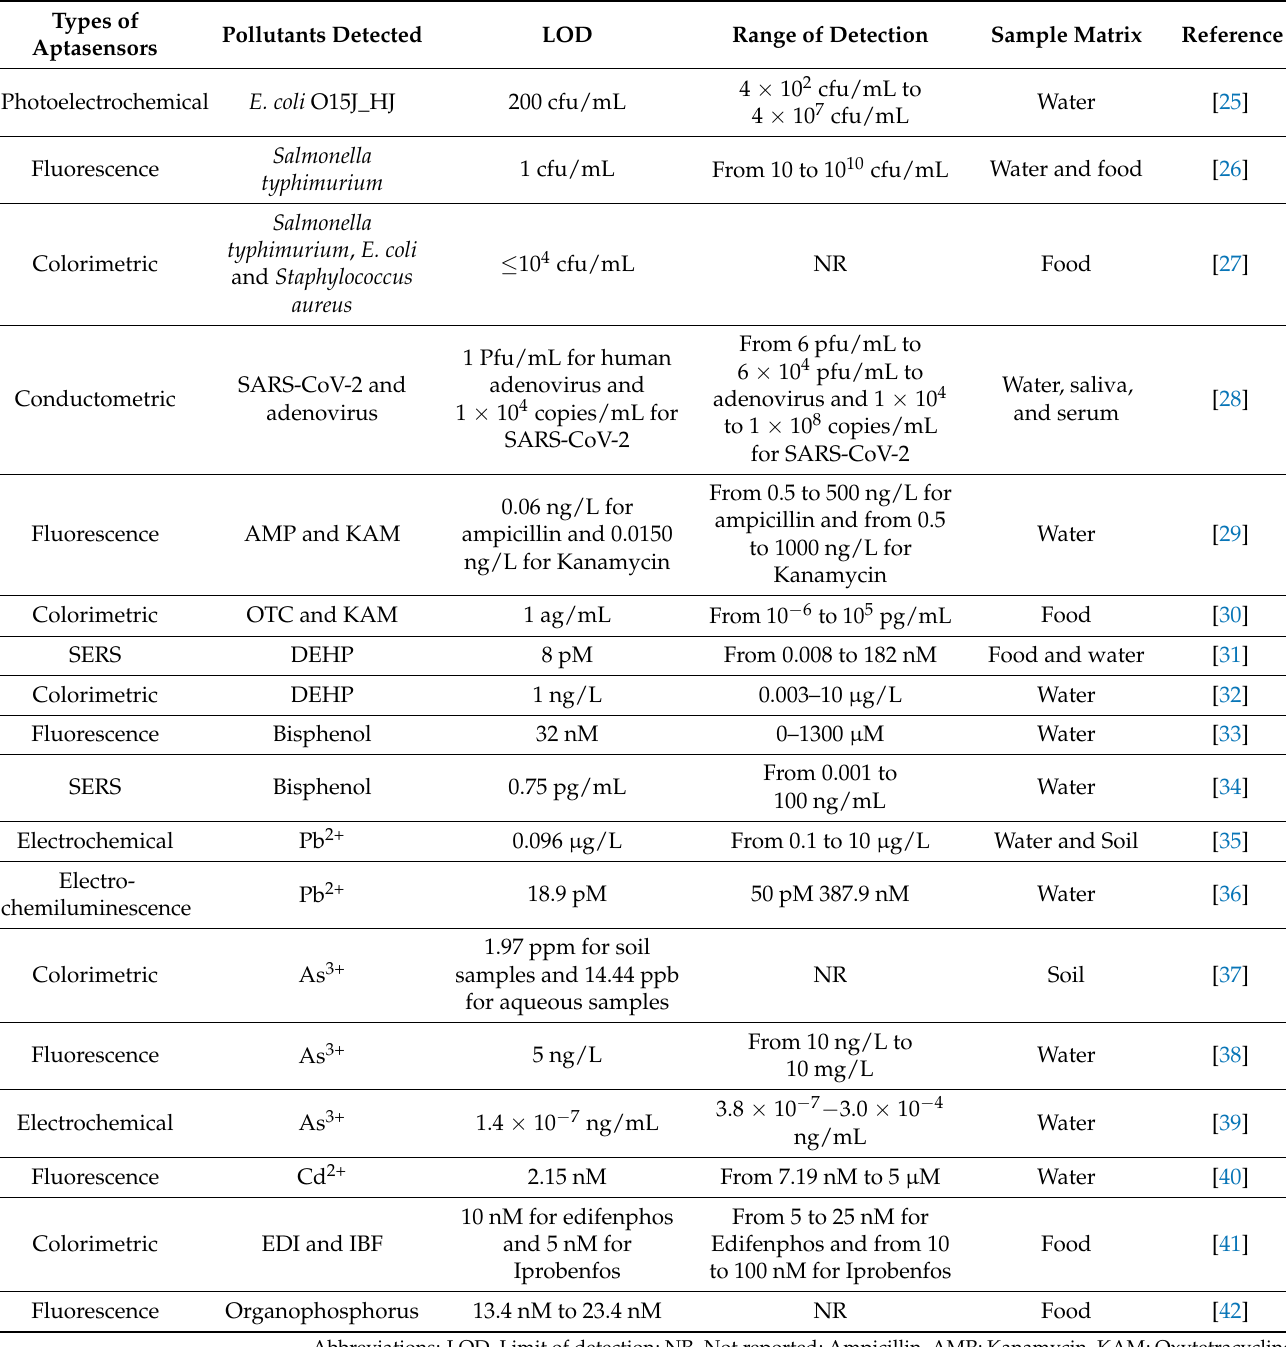
Table 1. Summary of the application of aptasensors for the detection of